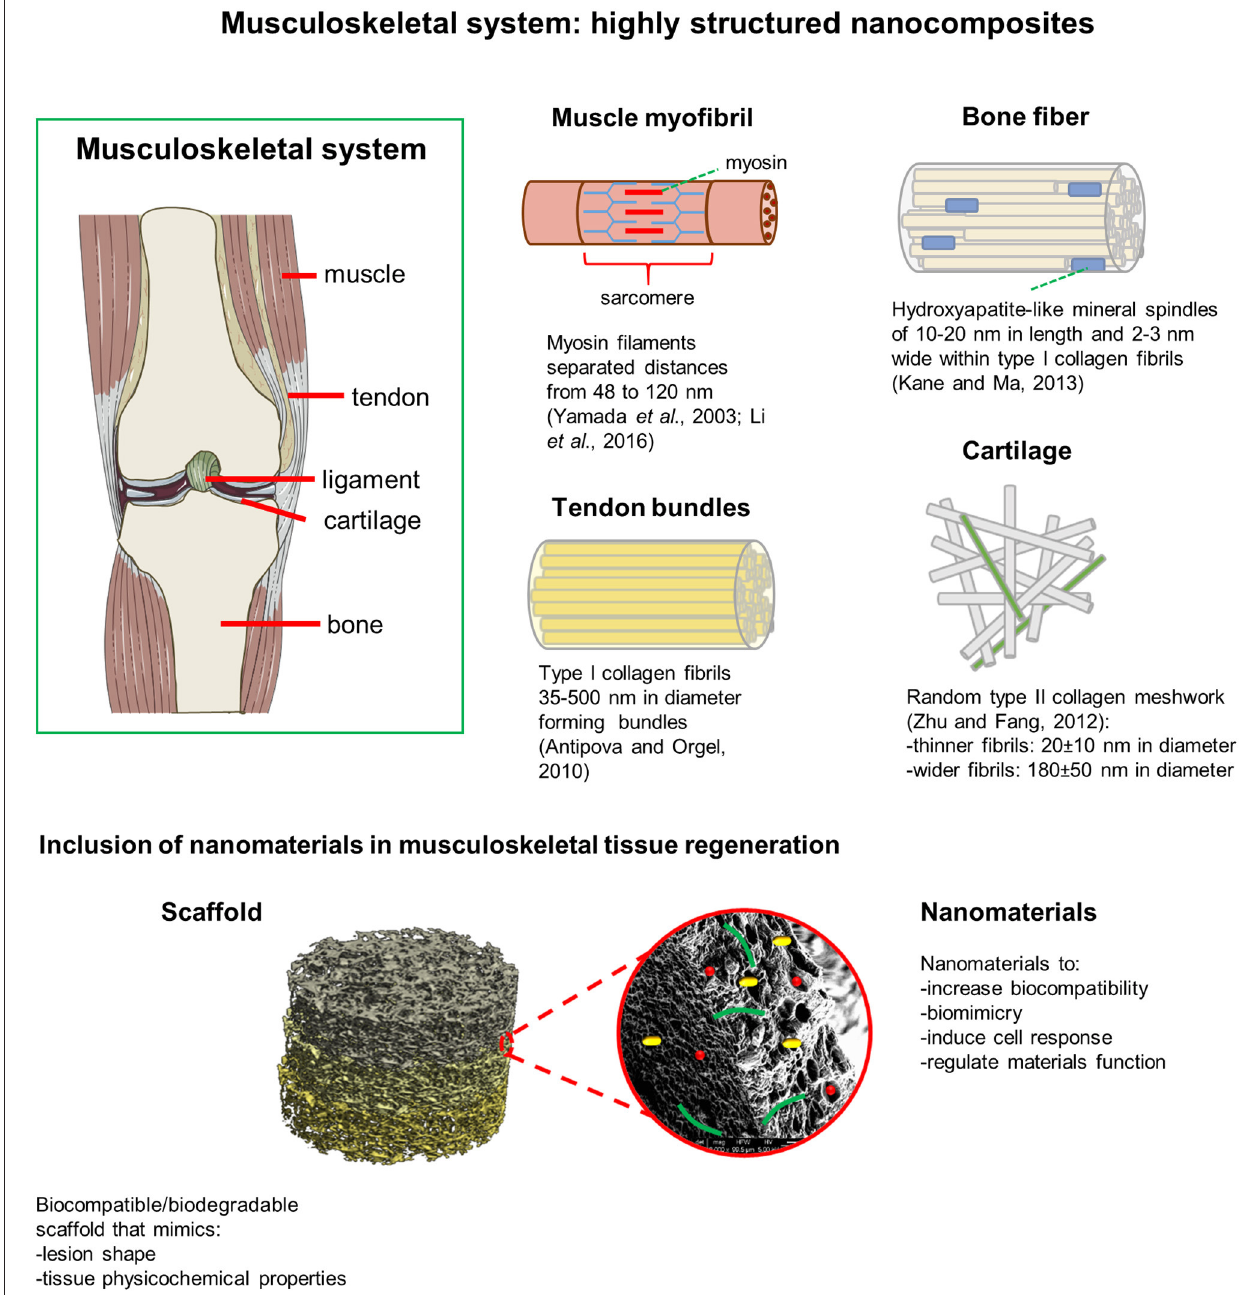
when 300 µ m coral microparticles were included at 1:1 weight ratio to nanofibrous mat. Microparticles also modified the material elastic modulus, which increased from 3.547 ±